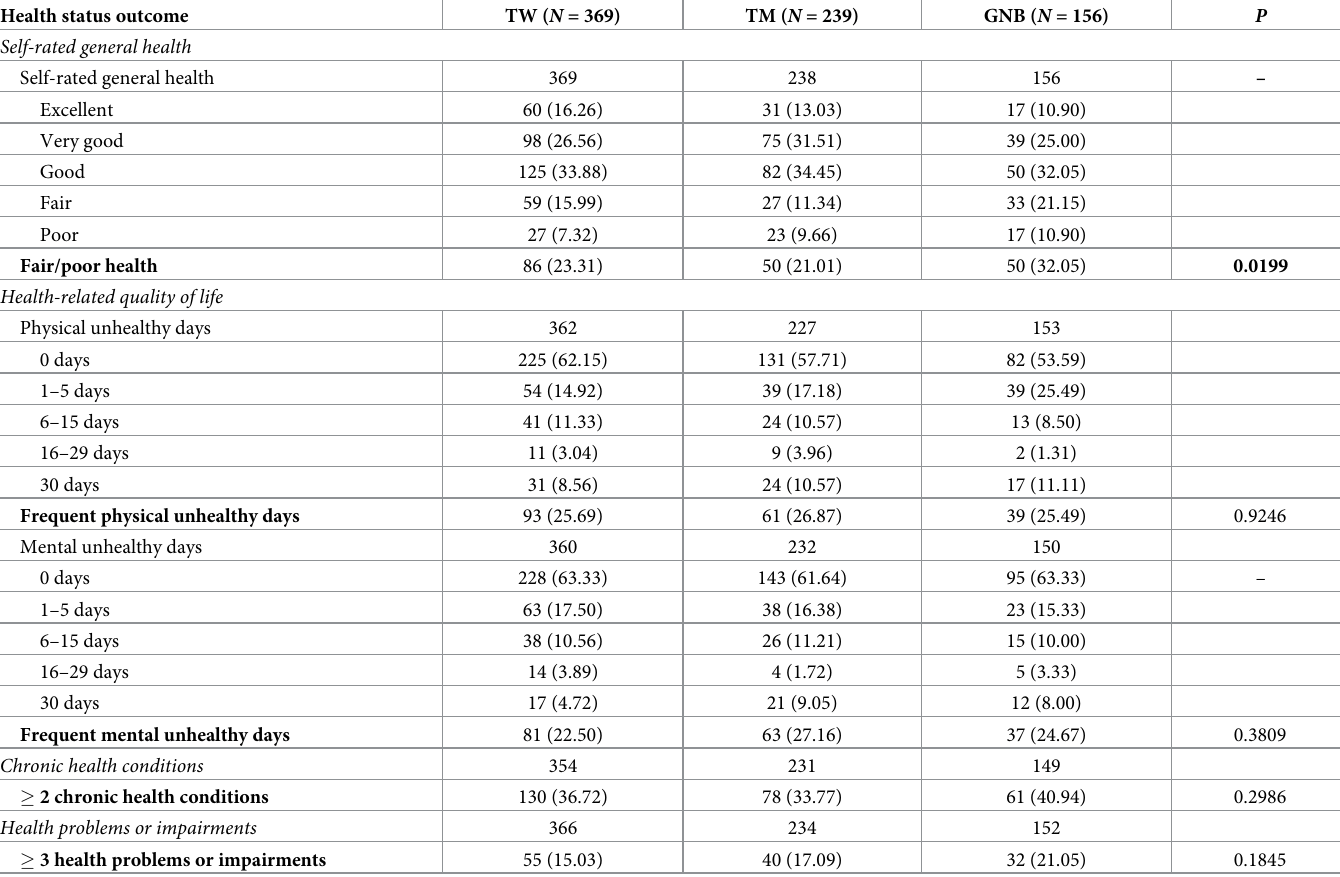
Table 3. Bivariate model results: Study group and health